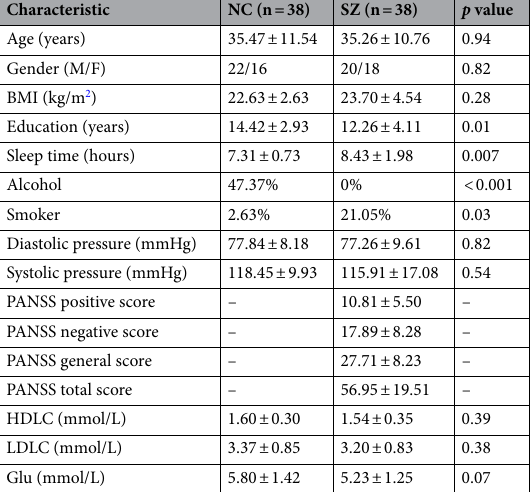
Table 1. Demographic characteristics of the NC and SZ patients. BMI, body mass index; HDLC, high-density lipoprotein cholesterol; LDLC, low-density lipoprotein cholesterol; Glu,